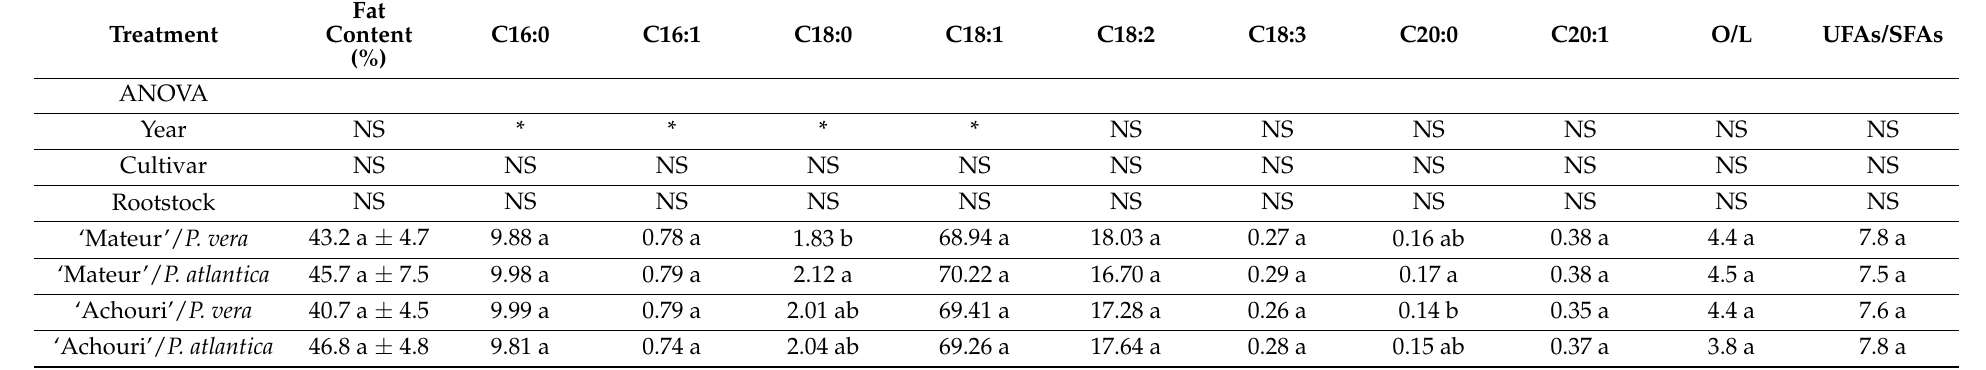
Fat content values, Oleic/Linoleic acid ratio (O/L) and Unsaturated/Saturated fatty-acid ratio (UFAs/SFAs) for 2015 and 2016 only; Fatty acids: C16:0: Palmitic acid; C16:1: Palmitoleic acid; C18:0: Stearic acid; C18:1: Oleic acid; C18:2: Linoleic acid; C18:3: Linolenic acid; C20:0: Arachidic acid; and C20:1: Gadoleic acid; Values followed by the same letter, within the same column, are not significantly different ( p < 0.05); NS: not significant ( p < 0.05); * Significant ( p ≤